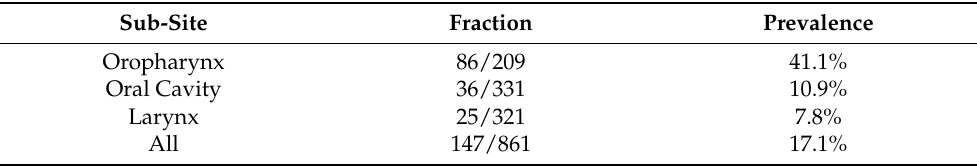
Table 5. HPV DNA prevalence for oropharyngeal, oral cavity, and laryngeal cancer diagnosed in Ireland between 1994 and 2013.